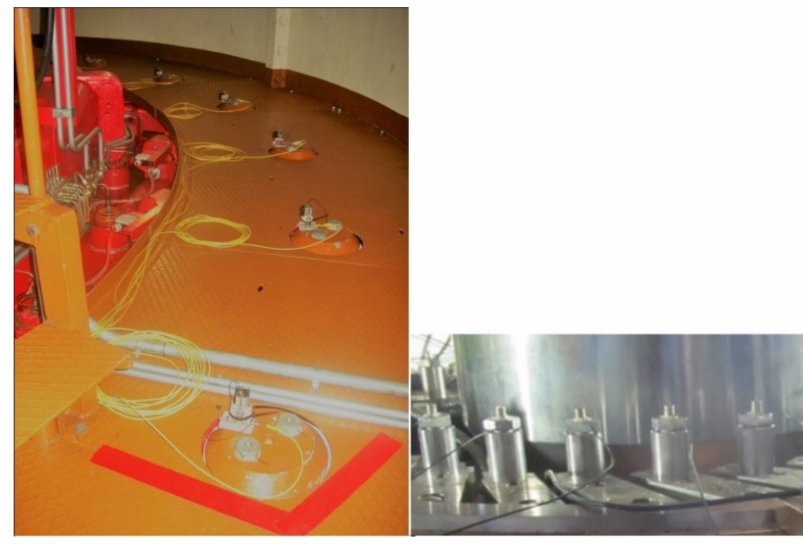
Figure 2. Vibro-acoustical sensors on the guide-vane